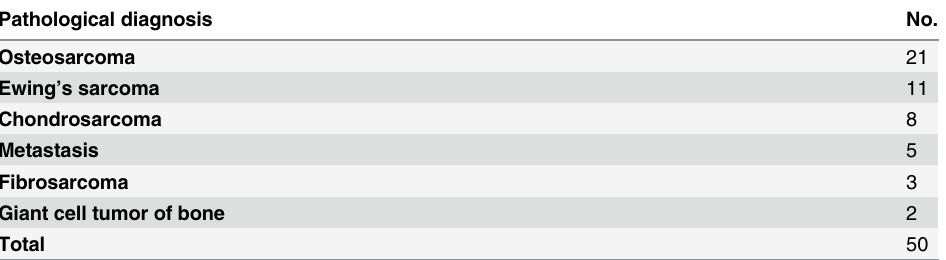
Table 1. A list of the pathological diagnoses. Pathological diagnosis No. Osteosarcoma 21 Ewing ’ s